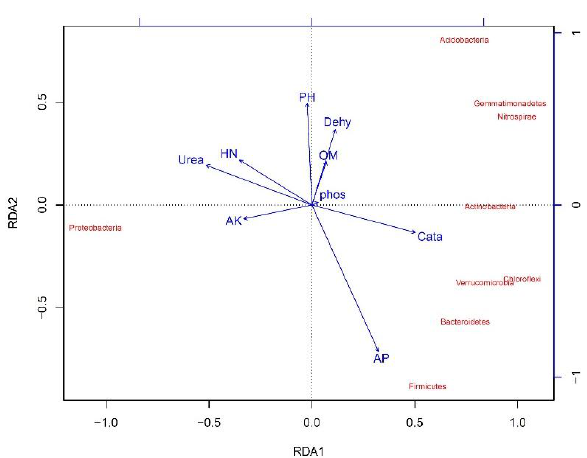
Figure 10. Ordination plots from a redundancy analysis (RDA) used to explore the relationships between the soil bacterial community and environmental variables. The arrows indicate the lengths and angles between explanatory and response variables and reflect their correlations. Samples from different concentrations of graphene treatments and different incubation times are marked with different colors. (OM = organic matter contents; HN = hydrolytic nitrogen contents; AP = available